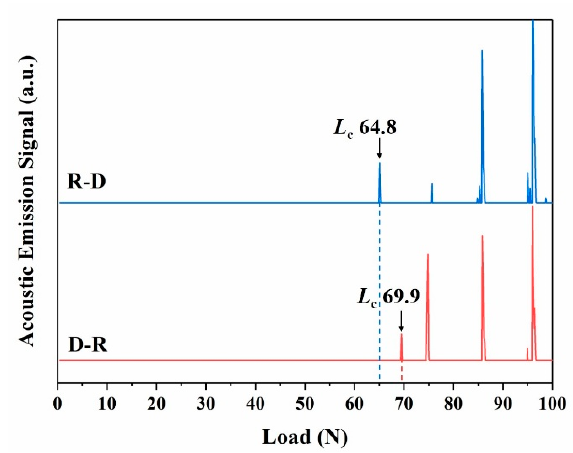
Figure 4. Acoustic emission signal curves of the coatings.